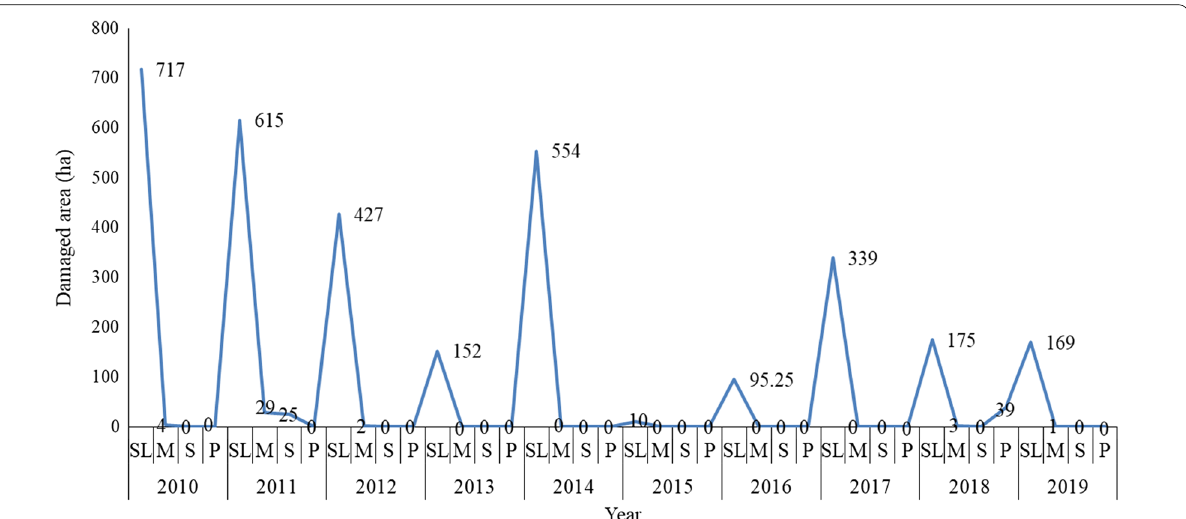
Fig. 6 Damaged area of corn field caused by Spodoptera litura in Lampung during 2010–2019. SL: slightly damage (1 to medium damage (> 25 to